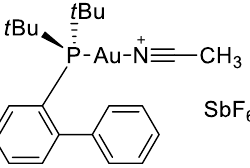
Figure 2. Chemical structure of JohnPhosAu(MeCN)SbF 6 catalyst.